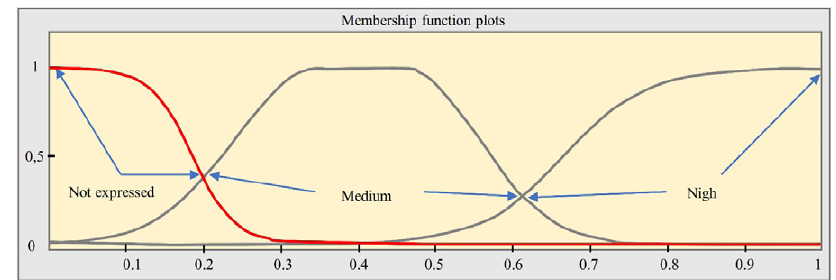
Figure 2. Linguistic estimate’s terms of variable “measure of